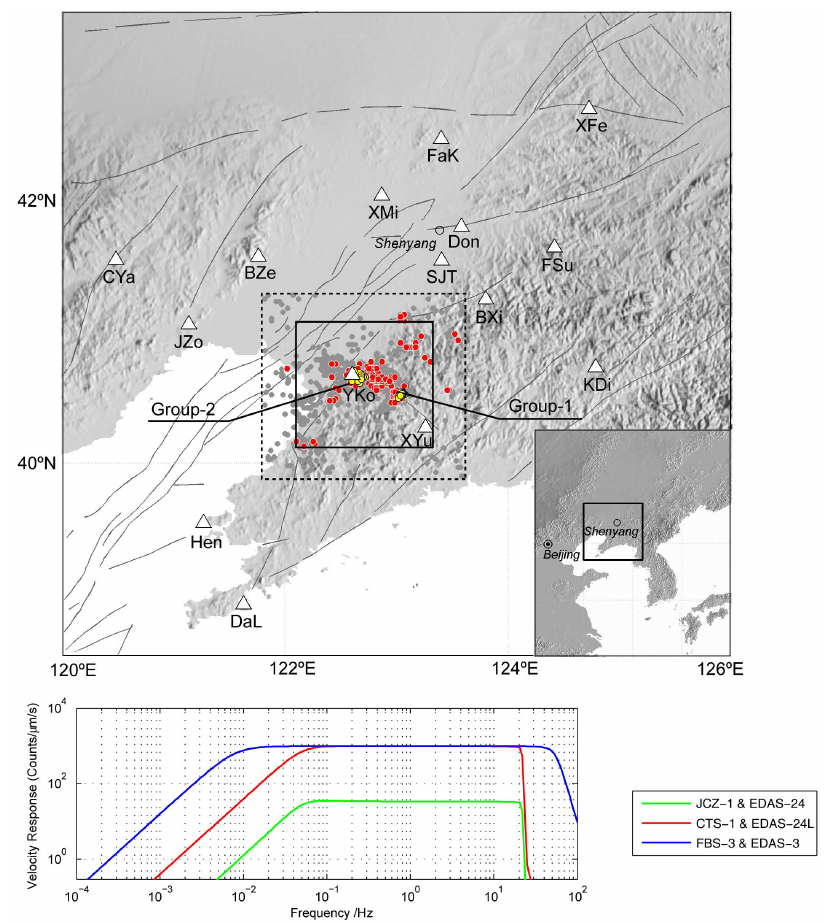
Fig. 2. (Top) Distribution of earthquakes and seismic stations used for this study. Earthquakes are shown by gray dots. Shown in red are the “repeating earthquakes” identified by waveform cross-correlation. Yellow dots show the two “multiplets” under consideration. Gray lines indicate tectonic faults. Box in the indexing figure indicates the whole region under consideration. In the region, box with solid lines highlights the study region (40.1 ∼ 41.1 ◦ N, 122 ∼ 123.4 ◦ E) as shown in Figs. 1 and 4, encompassed by a larger box with dashed lines (39.9 ∼ 41.3 ◦ N, 121.8 ∼ 123.6 ◦ E) to ensure the completeness of the “repeater” catalogue. Seismic stations are shown by triangles, with letters nearby indicating the name of the station. (Bottom) Instrumental response of the seismographs (from the Data Center of Liaoning Digital Seismograph